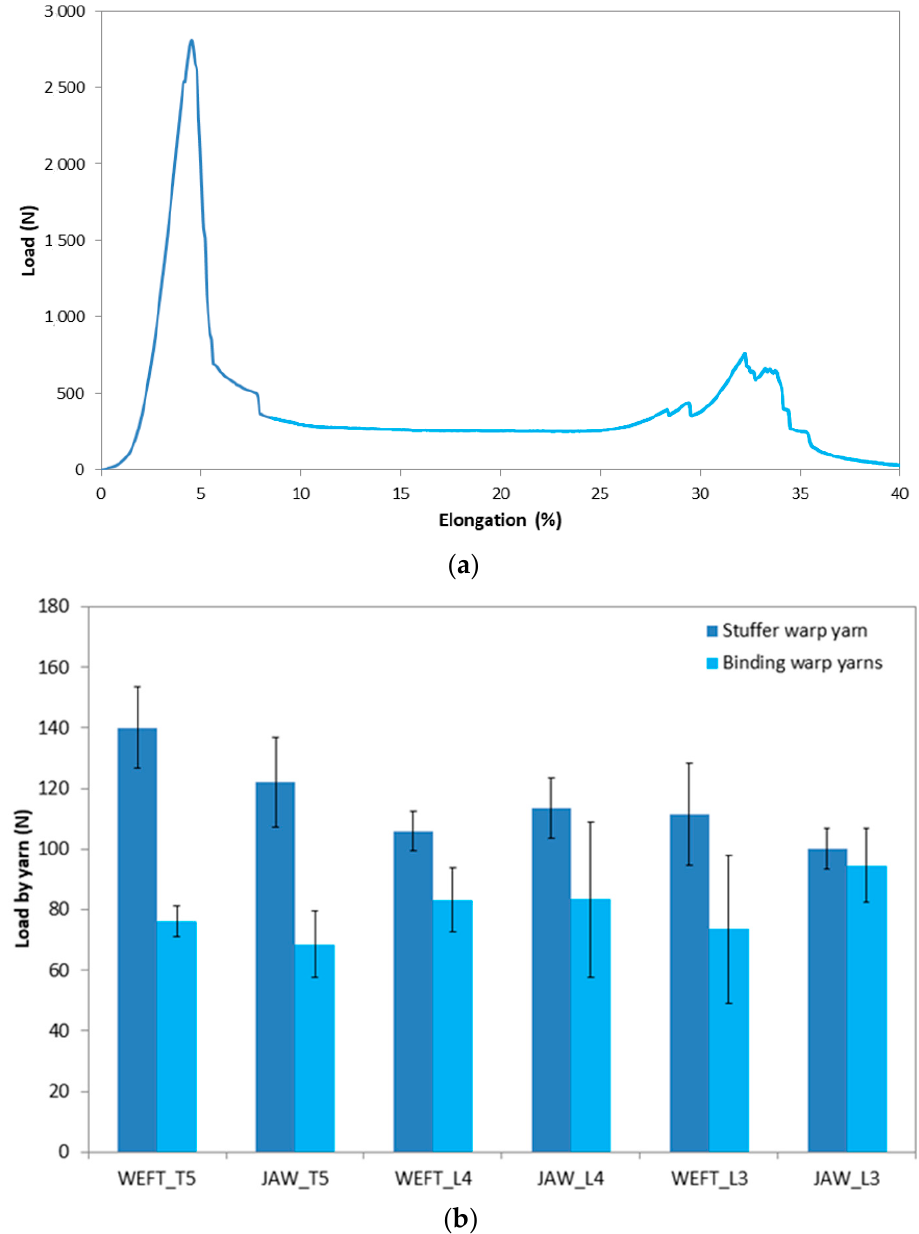
Figure 9. Tensile test in warp direction. ( a ) Example of structure WEFT_T5. ( b ) Maximum load of the six different 3D warp interlock structures.